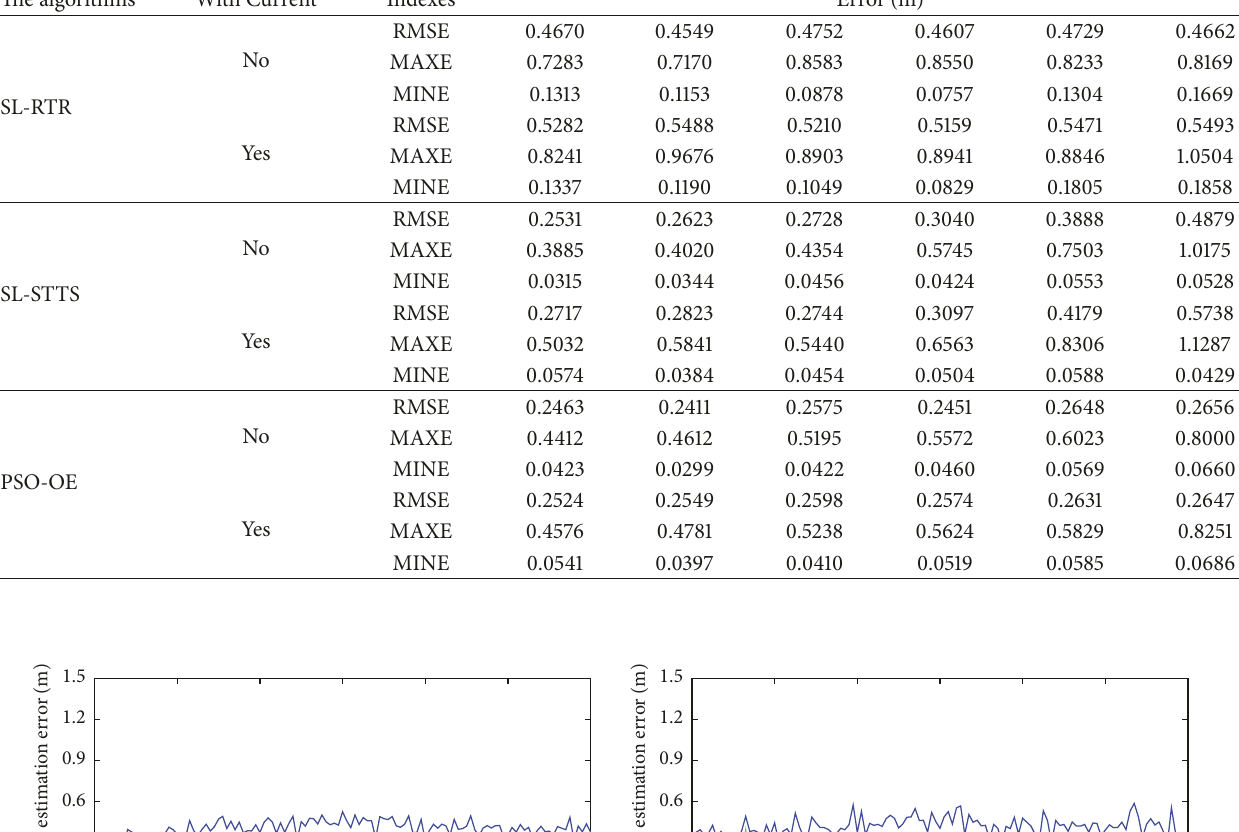
Table 4: The localization error of the localization task by different angle measurement noise level.